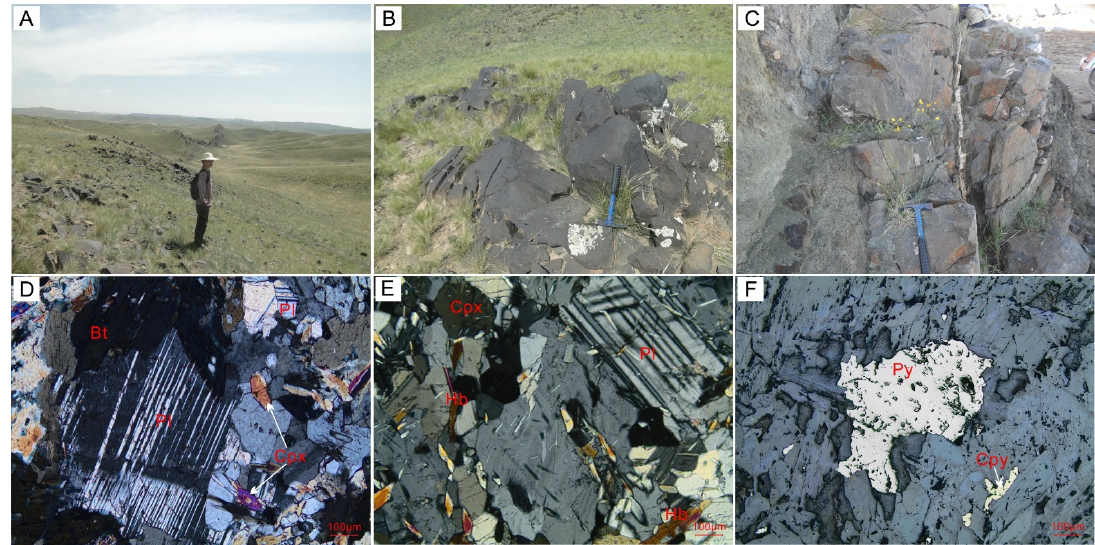
Figure 3. Representative field photographs and photomicrographs (cross-polarized light, D and E ; single-polarized light, F ) of the Haoyaoerhudong gabbro. ( A ) EW-trending gabbro dike; ( B ) Outcrop of the Haoyaoerhudong gabbro; ( C ) Thin felsic vein cut through the gabbro; ( D , E ) Mineral assemblage of the Haoyaoerhudong gabbro; ( F ) Metal minerals of the gabbro. Mineral abbreviations: Cpx, clinopyroxene; Bi, biotite; Hb, hornblende; Pl, plagioclase; Cpy; chalcopyrite; Py,